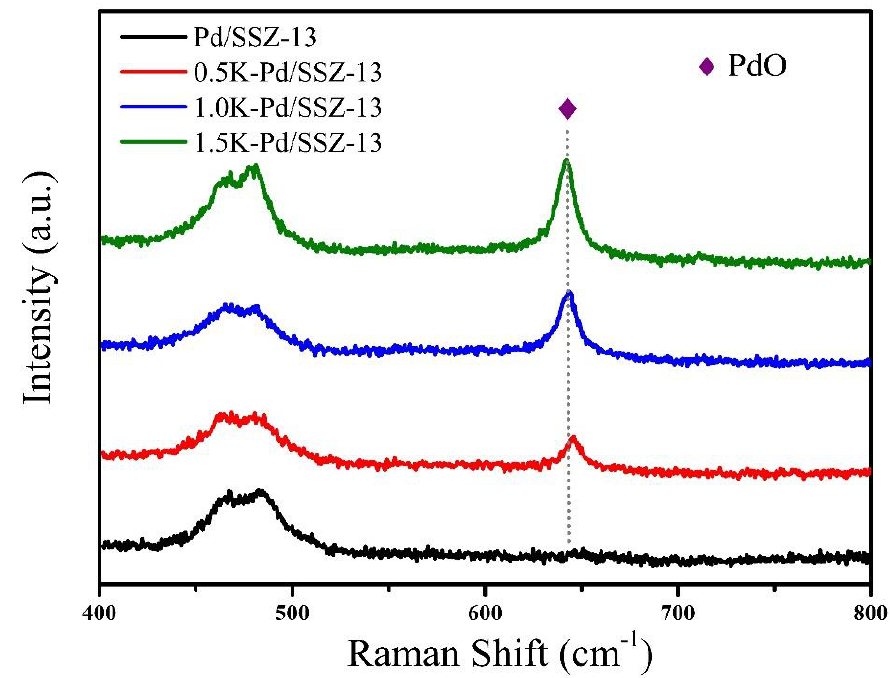
Figure 4. Raman spectra of the Pd/SSZ-13 and K-deactivated samples.